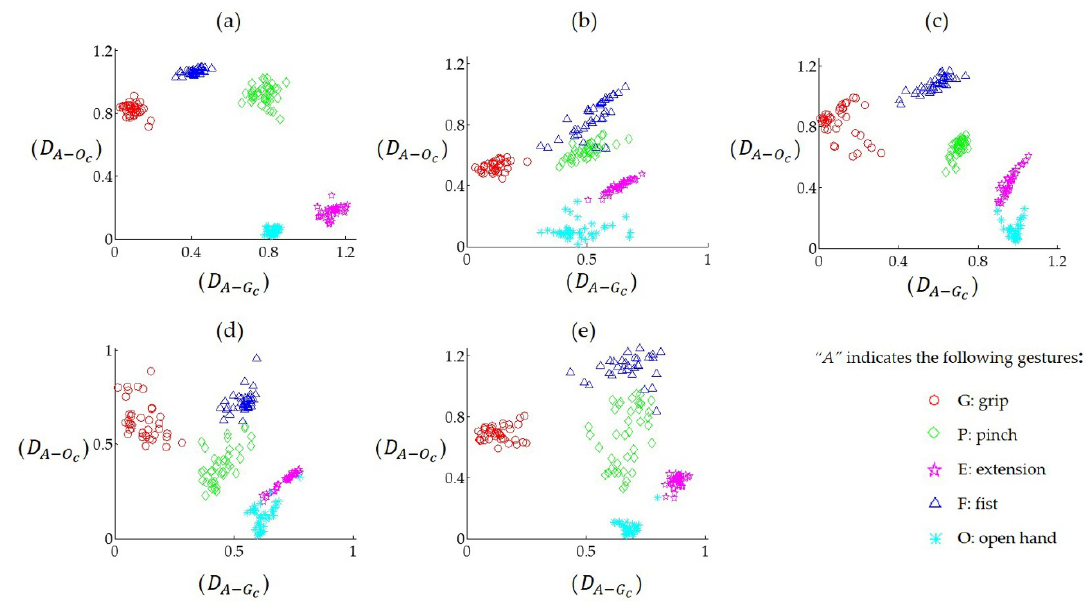
) was the distance ) was the 𝐷𝐷 𝐴𝐴−𝐺𝐺 𝑐𝑐 ) was the distance c 𝐷𝐷 𝐴𝐴−𝐺𝐺 𝑐𝑐